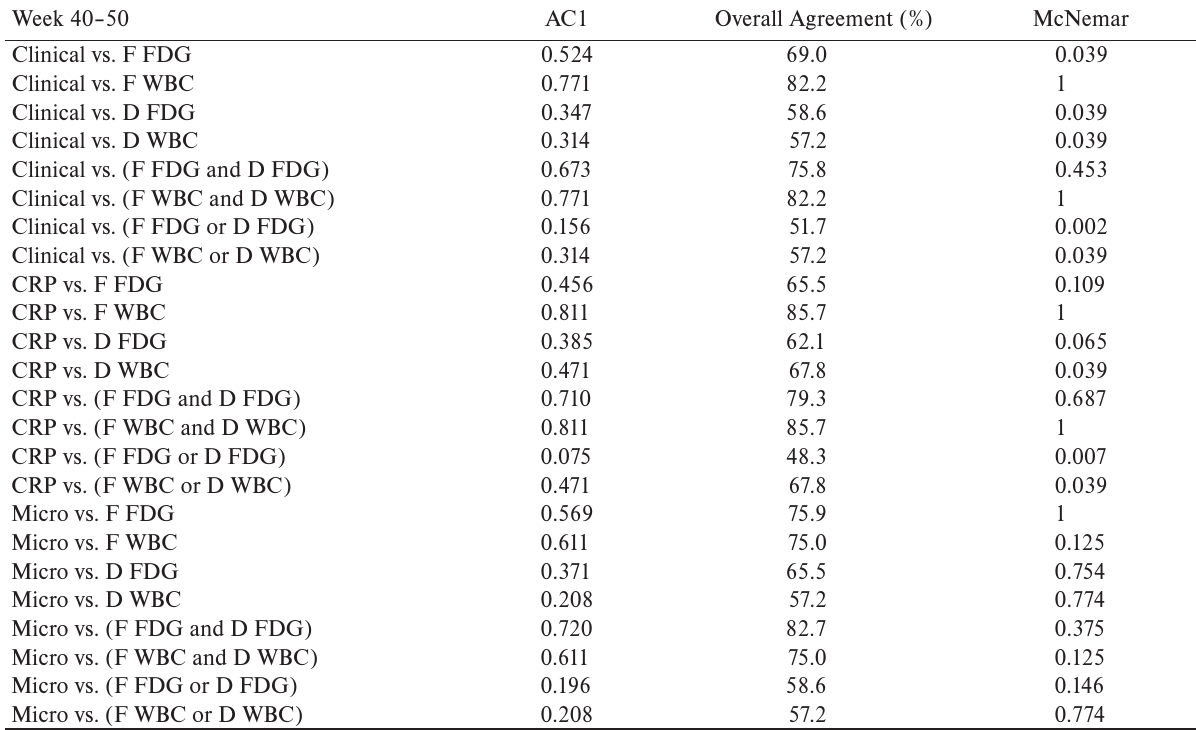
table 2c. Evaluation of agreement between reference parameters and diffuse or focal 18 F-FDG PET/CT and 99m Tc-HMPAO-WBC SPECT/CT findings at 40 to 50 weeks after